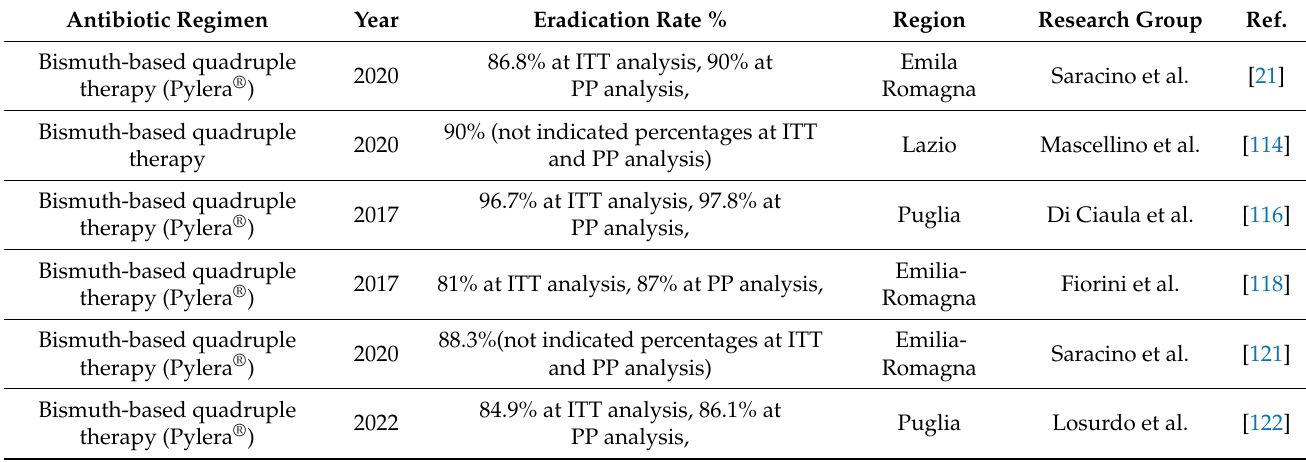
Table 11. Eradication Rate of bismuth-based regimens in treatment experienced